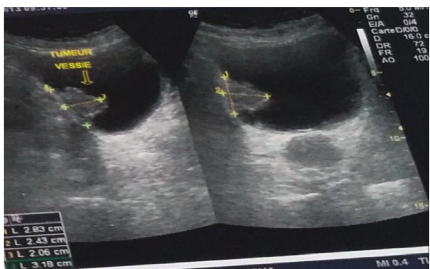
Figure 2: Moderately differentiated and keratinizing squamous